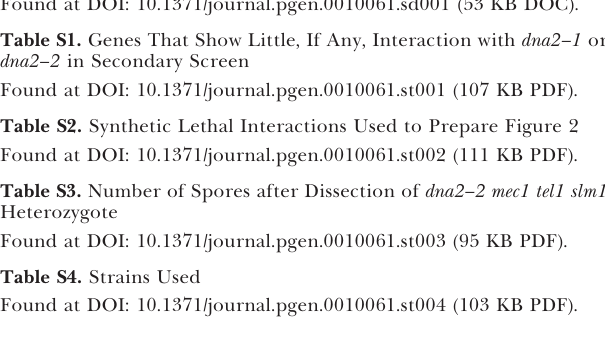
Table S1. Genes That Show Little, If Any, Interaction with dna2–1 or dna2–2 in Secondary Screen Table S2. Synthetic Lethal Interactions Used to Prepare Figure 2 Table S3. Number of Spores after Dissection of dna2–2 mec1 tel1 slm1 Heterozygote Table S4. Strains